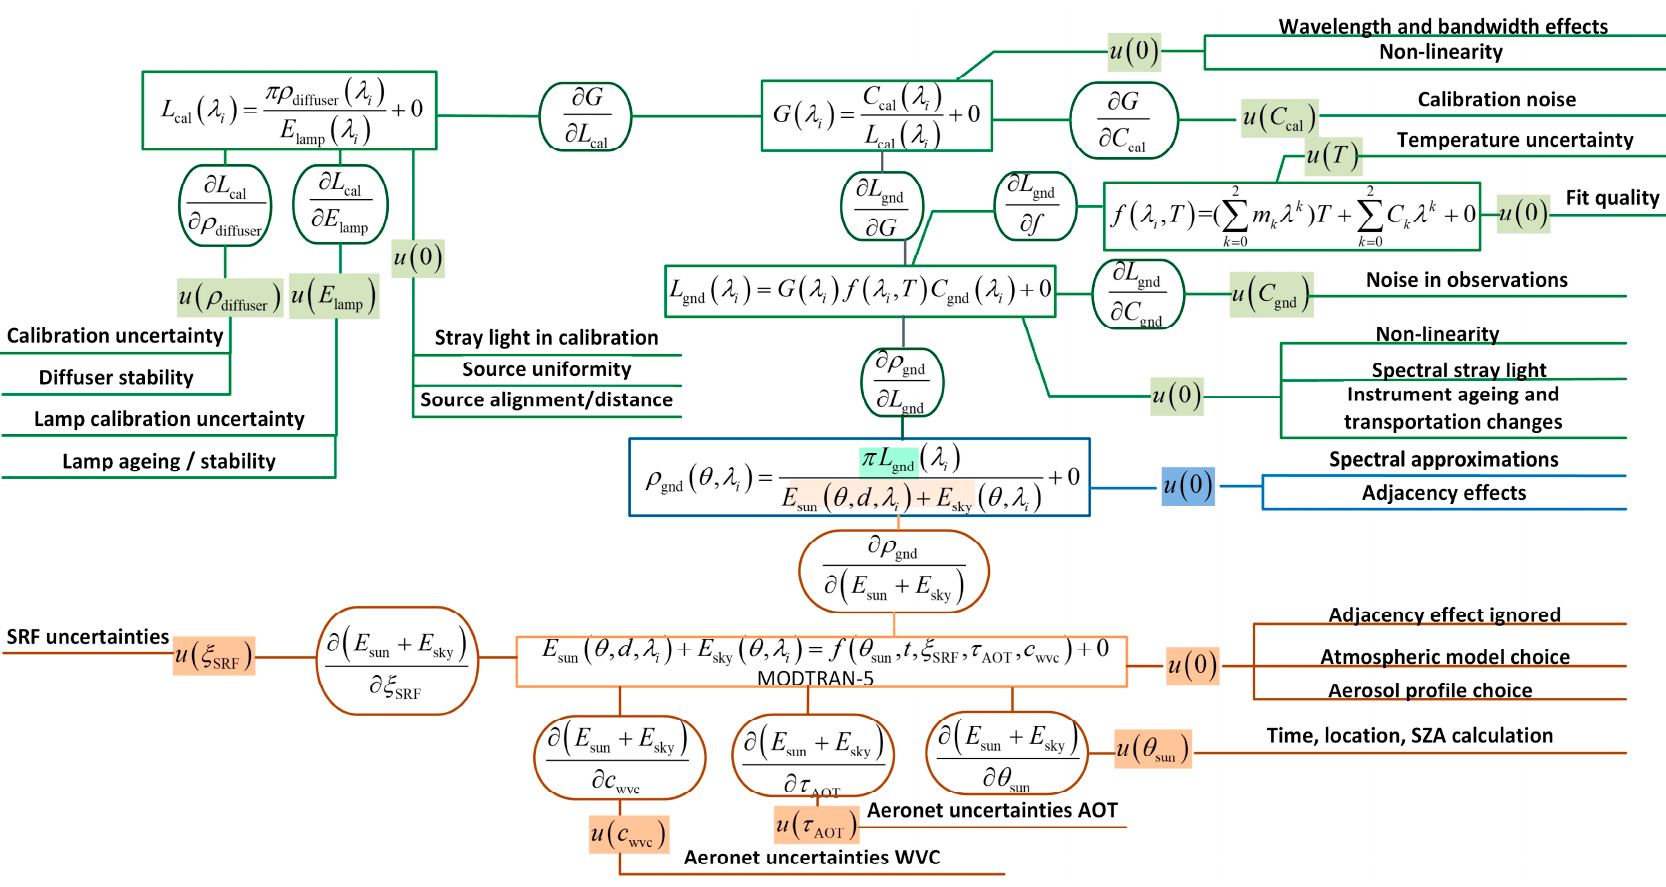
Figure A1. Uncertainty tree diagram for the Baotou measurements of ground spectral